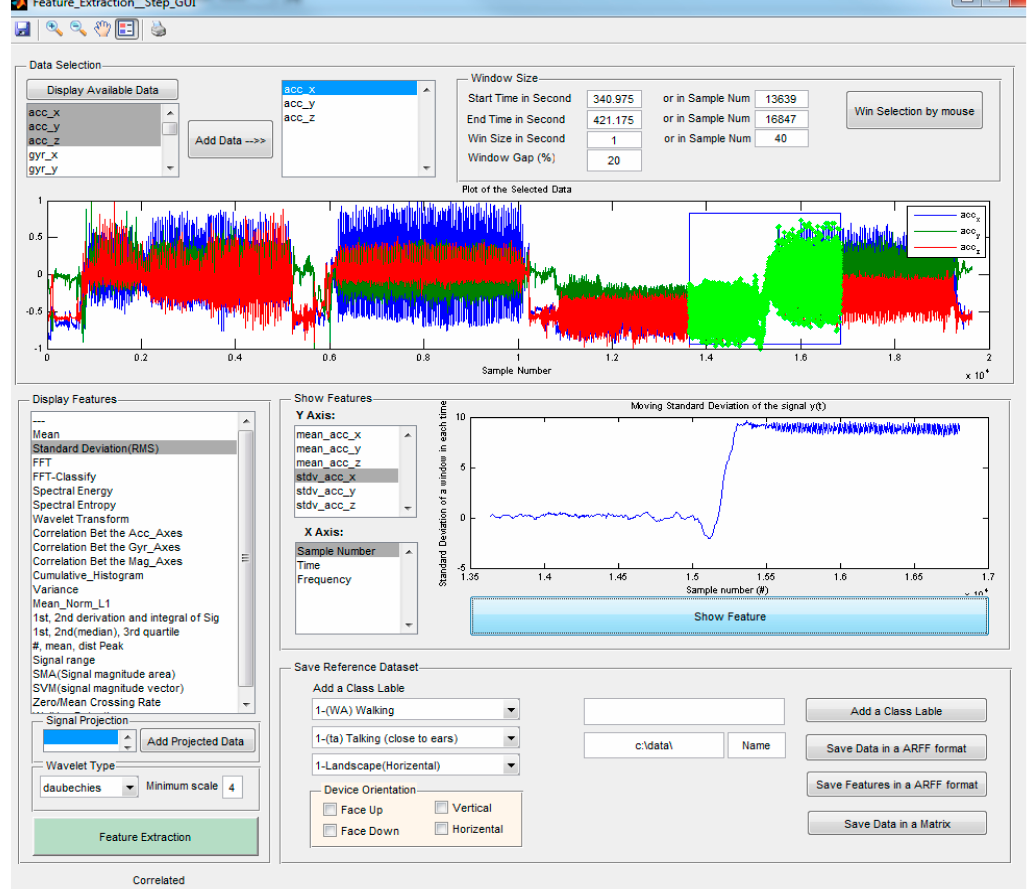
Figure 9. Feature extraction GUI from activity recognition module (From left to right and up to down, this GUI includes: Data Selection, Window Size, Features, Show Feature and Save Dataset panels).